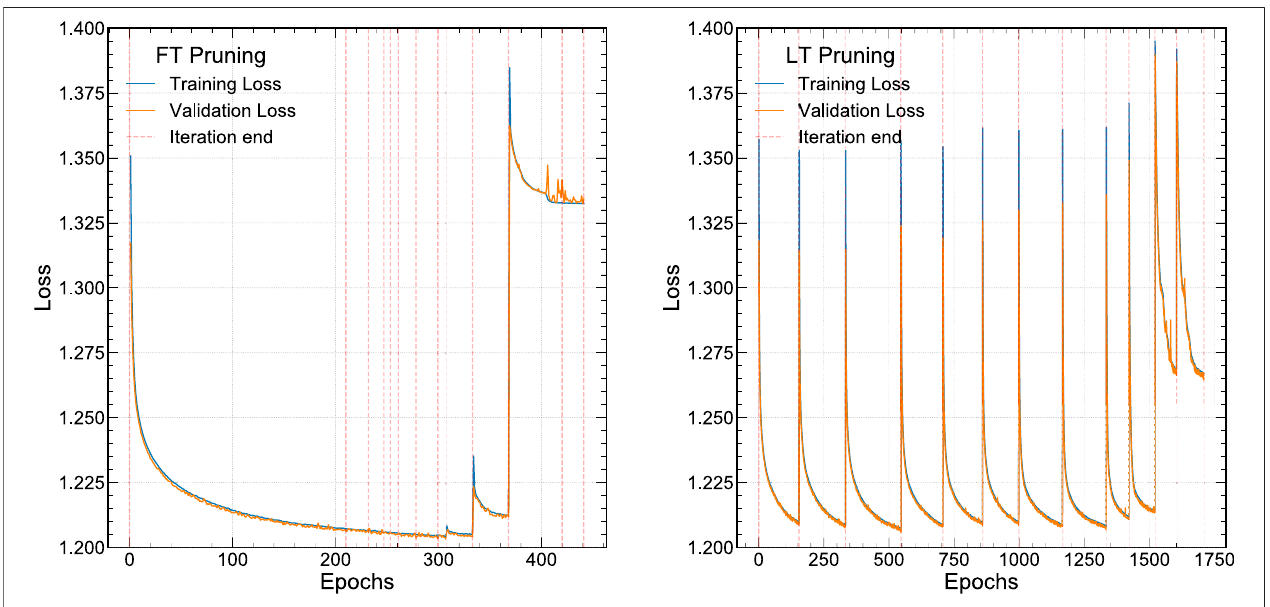
FIGURE2| Theloss functionfortheQAPprocedurefora6-bitjetclassi fi cation neuralnetwork.FTpruningisdemonstratedontheleft (A) and LTpruningisshown on the right (B) .